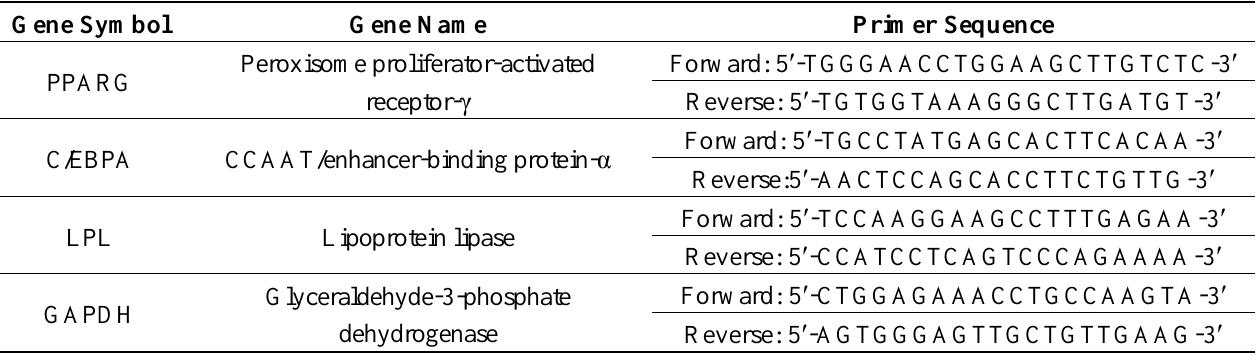
Table 1. Primer sequences for amplification of genes involved in adipose metabolism and for GAPDH internal